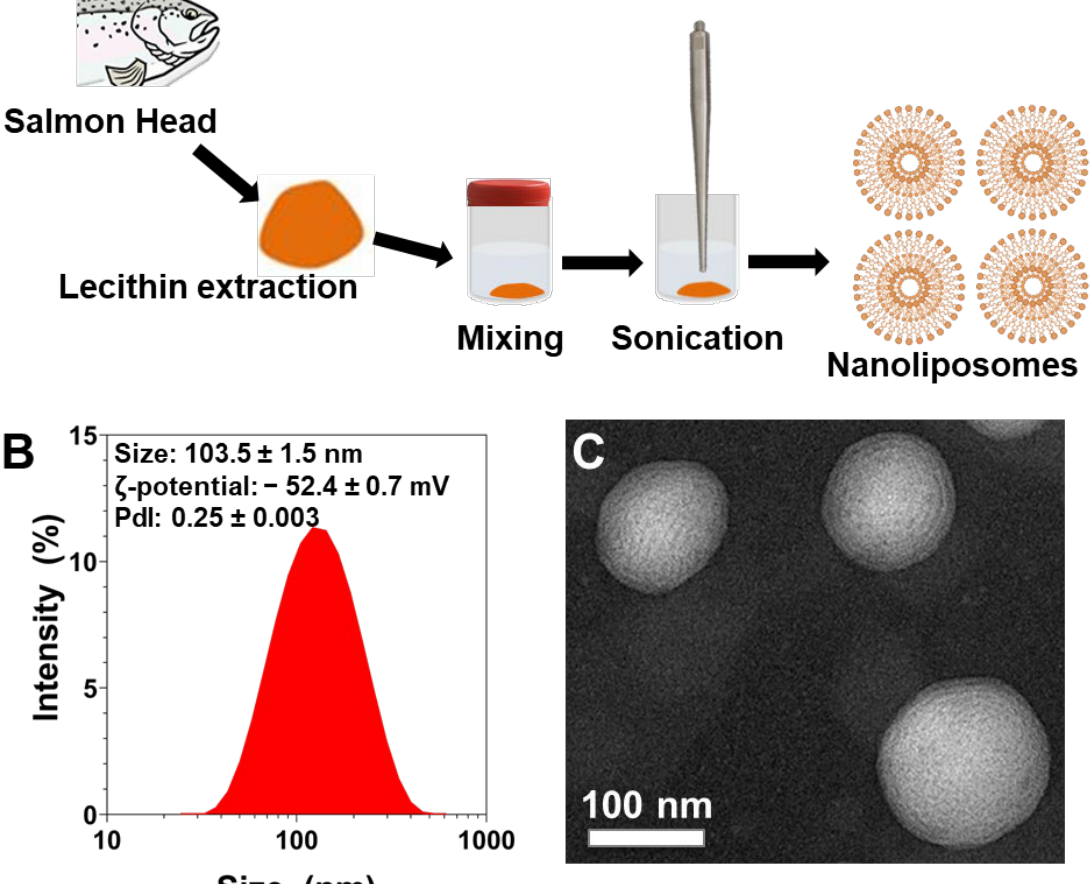
Figure 1. ( A ) Schematic representation of the fabrication process of salmon-derived nanoliposomes. ( B ) Size distribution measurements, and average size, ζ -potential, and polydispersity index values of liposomes measured by dynamic light scattering. The reported data are represented as mean ± SD of at least three individual experiments. ( C ) TEM image of nanoliposomes after their preparation.